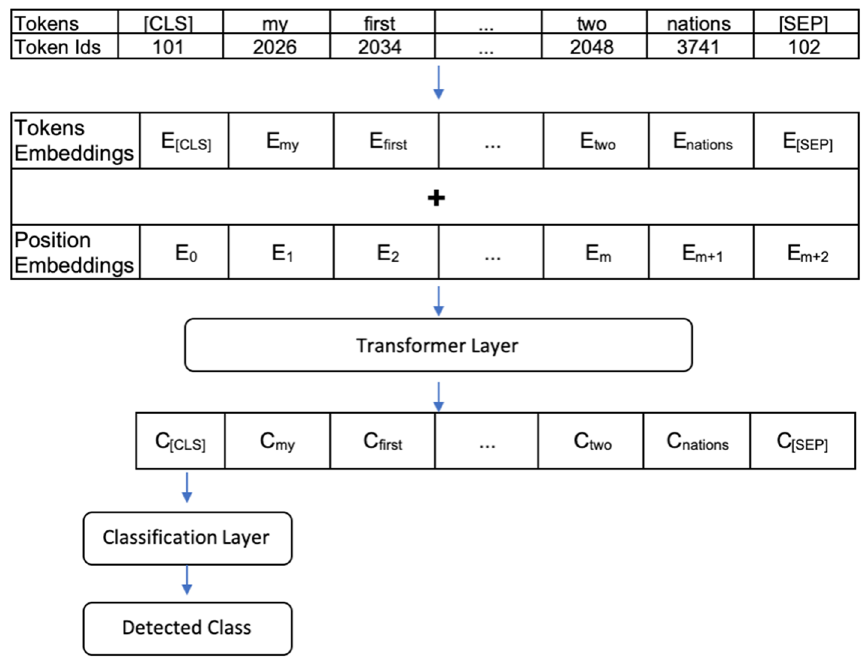
Fig. 3 Fine‑tuned BERT Architecture for Analysis of